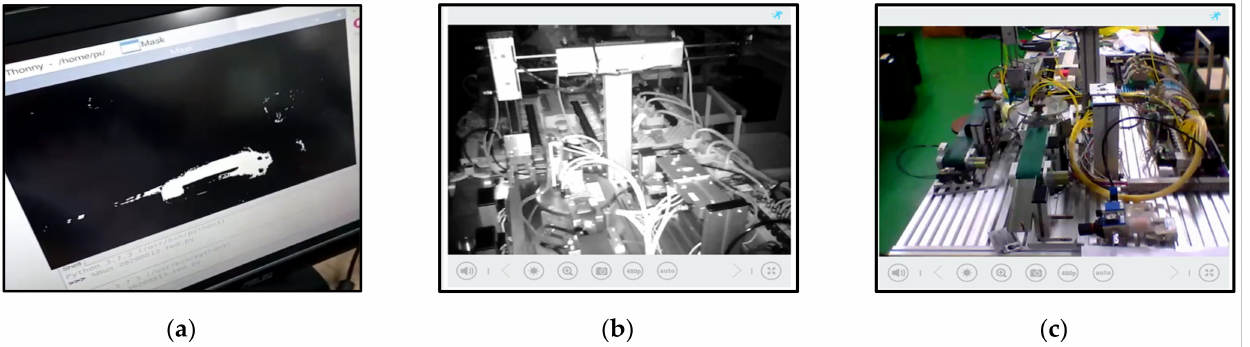
Figure 11. Physical visual image results of the cloud servo platform to remote and monitor: ( a ) color-recognition image of the production object, ( b ) night monitoring image: black and white image, ( c ) day monitoring image: color